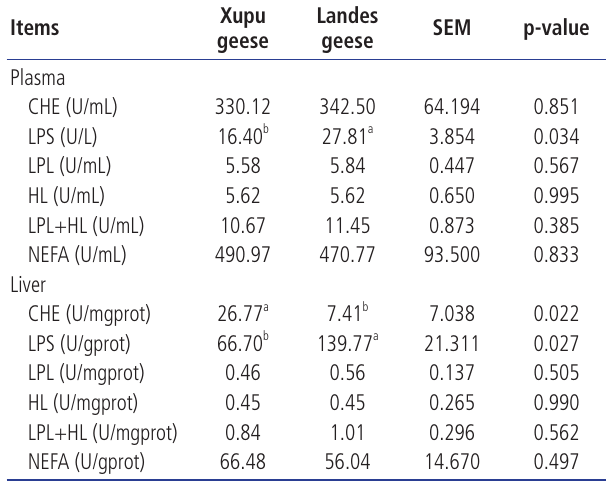
Table 6. Comparison of enzyme activities in blood and liver between overfed Xupu and Landes